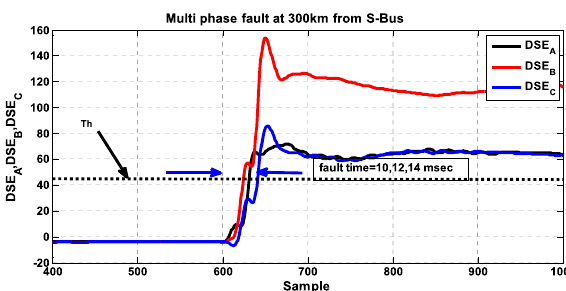
Fig. 10 Multi-phase fault at 300 km from B-S (A, B and C-phase at 0.3 s, 0.4 s and 0.5 s respectively)